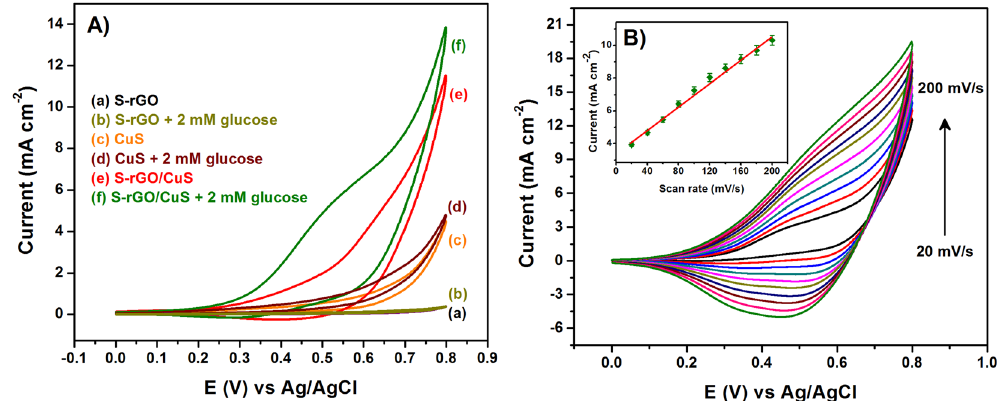
Figure 5. CV curves of glucose oxidation at S-rGO (a,b), CuS (c,d), S-rGO/CuS (e,f) in the absence and presence of 2 mM glucose in 0.1 M NaOH; scan rate 50 mV s − 1 ( A ). CV responses of the glucose oxidation at S-rGO/CuS in 0.1 M NaOH at various scan rates ranging from 20–200 mVs − 1 , inset shows the corresponding plot for the oxidation peak current vs. scan rate ( B ).